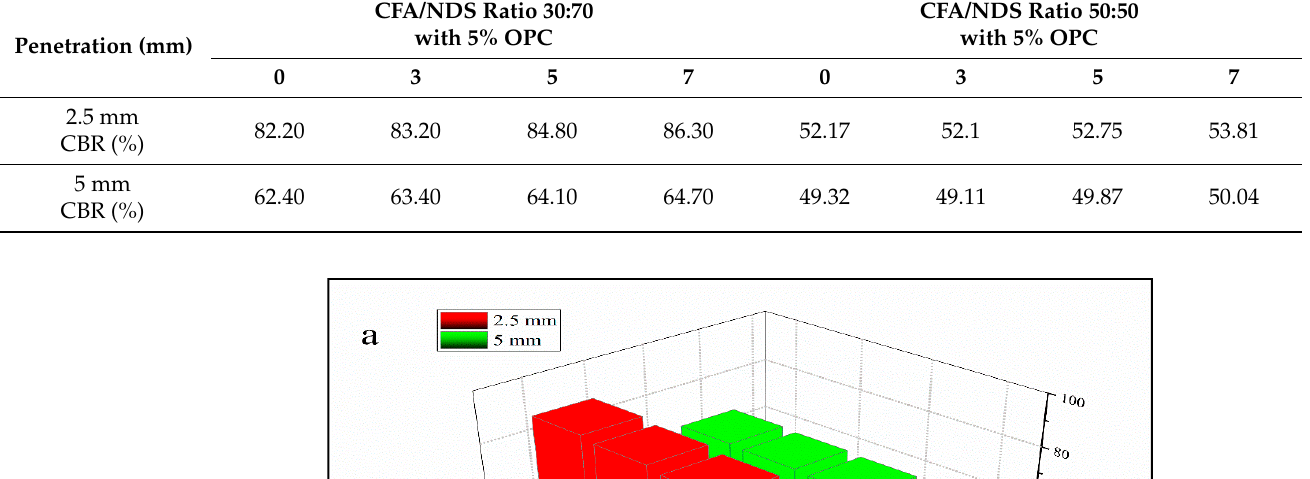
Table 4. Effect of fly ash on the CBR of cement-modified desert soil.